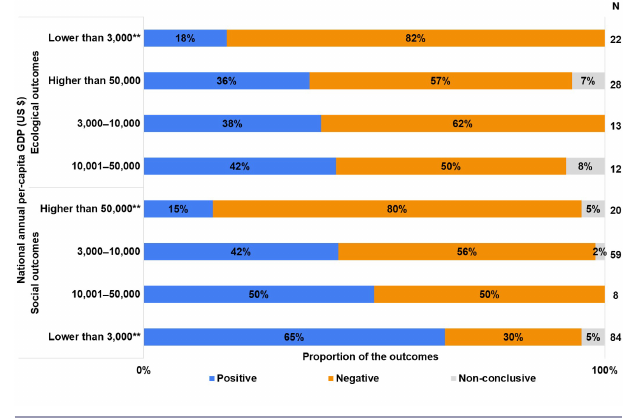
Fig. 6 . Ecological and social outcomes of urbanization on regional farming systems across national annual per-capita GDP levels (** Outcomes are statistically significant at p < or = 0.05).